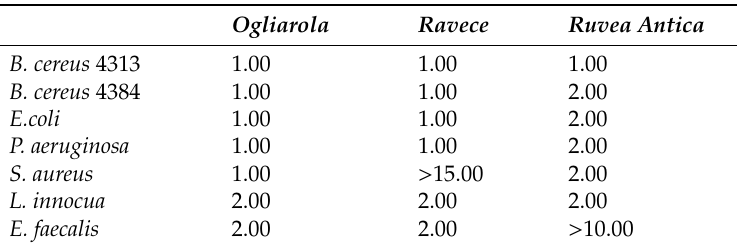
Table 2. Minimal Inhibitory Concentration (MIC, µ g / mL) of the PF extracts of ‘Ogliarola’, ‘Ravece’ and ‘Ruvea antica’ EVOOs, evaluated through the resazurin test, as reported in the Materials and Methods